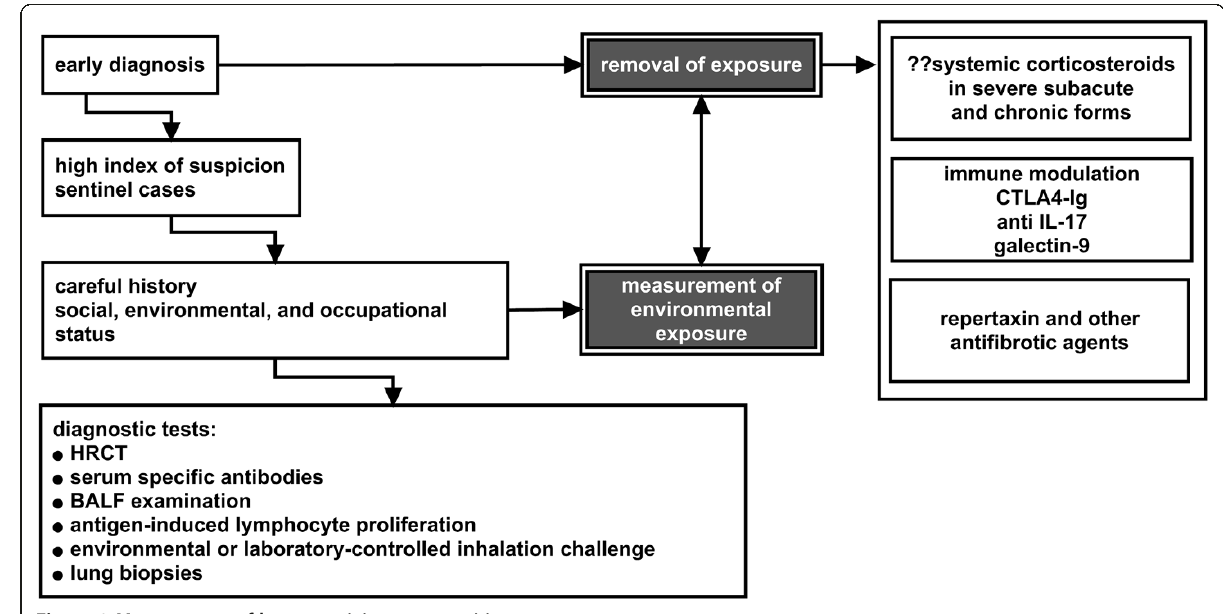
Figure 2 Management of hypersensivity